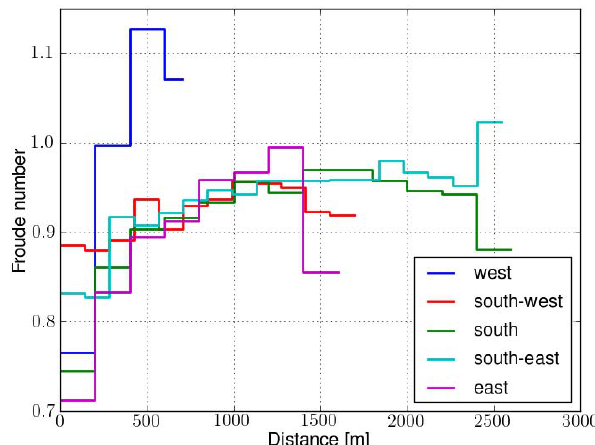
Fig. 6f. Froude numbers along wave gauge